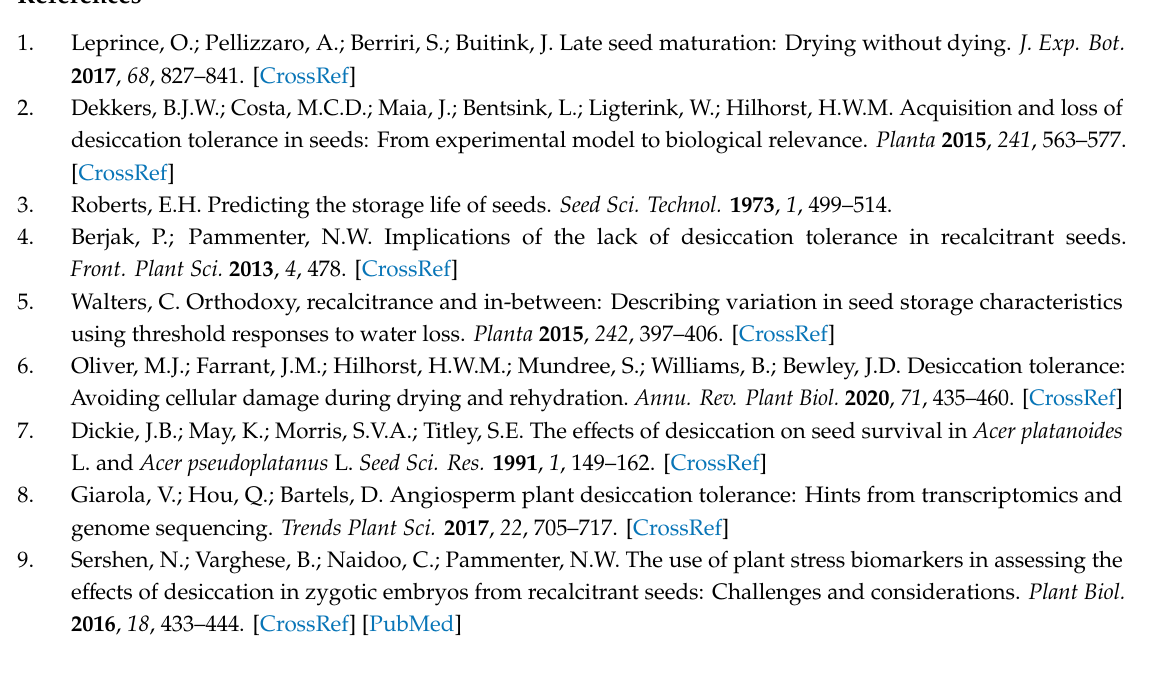
Figure S1: Chromatogram with standards, Figure S2: Representative gels, Figure S3: Soluble proteins, Figure S4: Negative blots, Figure S5: Correlation